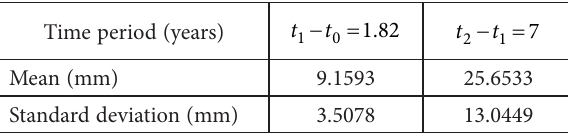
Table 4. Statistics of the inspection